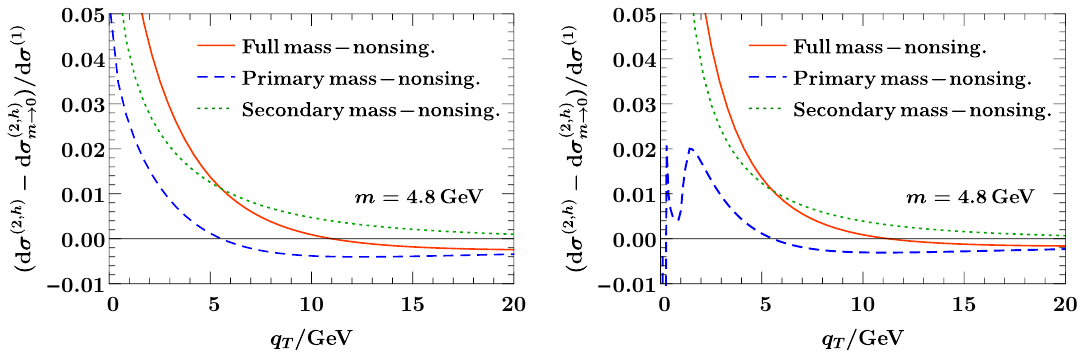
( (cid:11) 2 T 2 ) and ( (cid:11) 2 C F T F ), respectively. The results are given s s F O O ( (cid:11) s ) result including all (cid:13)avors. O